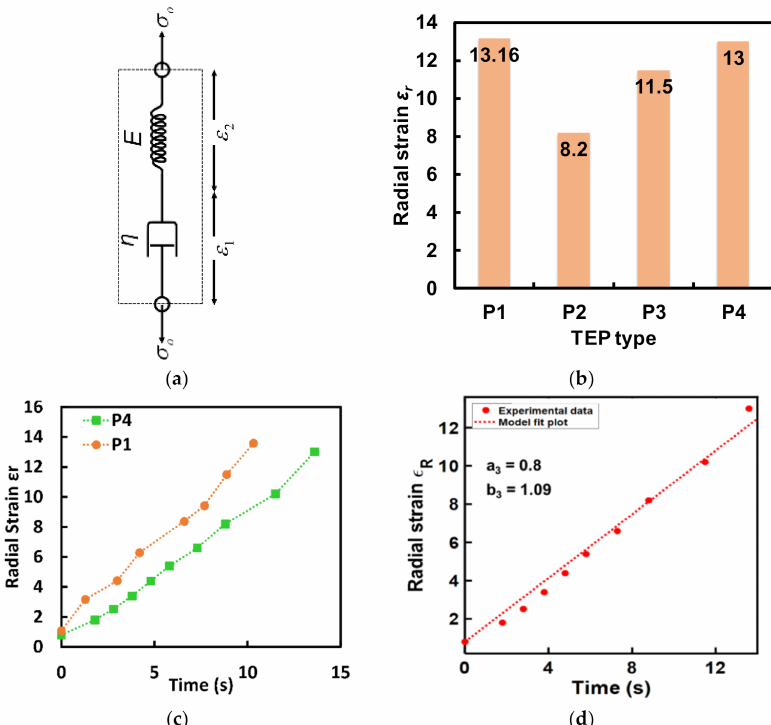
Figure 2. ( a ) A lumped parameter model of a Maxwell’s material representing a TEP material with the constitutive stresses and strain. ( b ) Maximum radial strain as observed for 4 different grades of TEP microspheres listed in Table 1. Polymer P1 and P4 show the maximum expanded capacity. ( c ) Experimental plot of time-dependent radial strain for TEP particles P1 and P4. ( d ) Experimental data for time-dependent radial strain for P4-TEP particles fitted with the strain equation for a Maxwell’s model showing excellent fit which means that TEP expansion can be modeled as a Maxwell’s